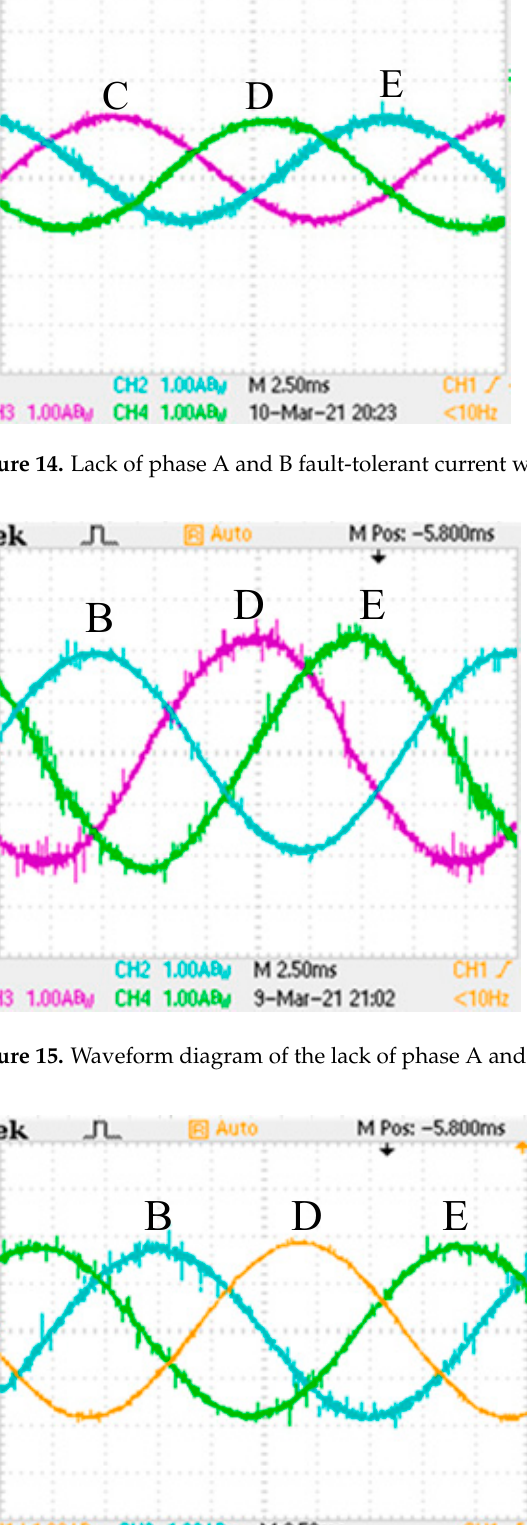
Figure 13. Waveform diagram of the lack of phase A and B current experiment.